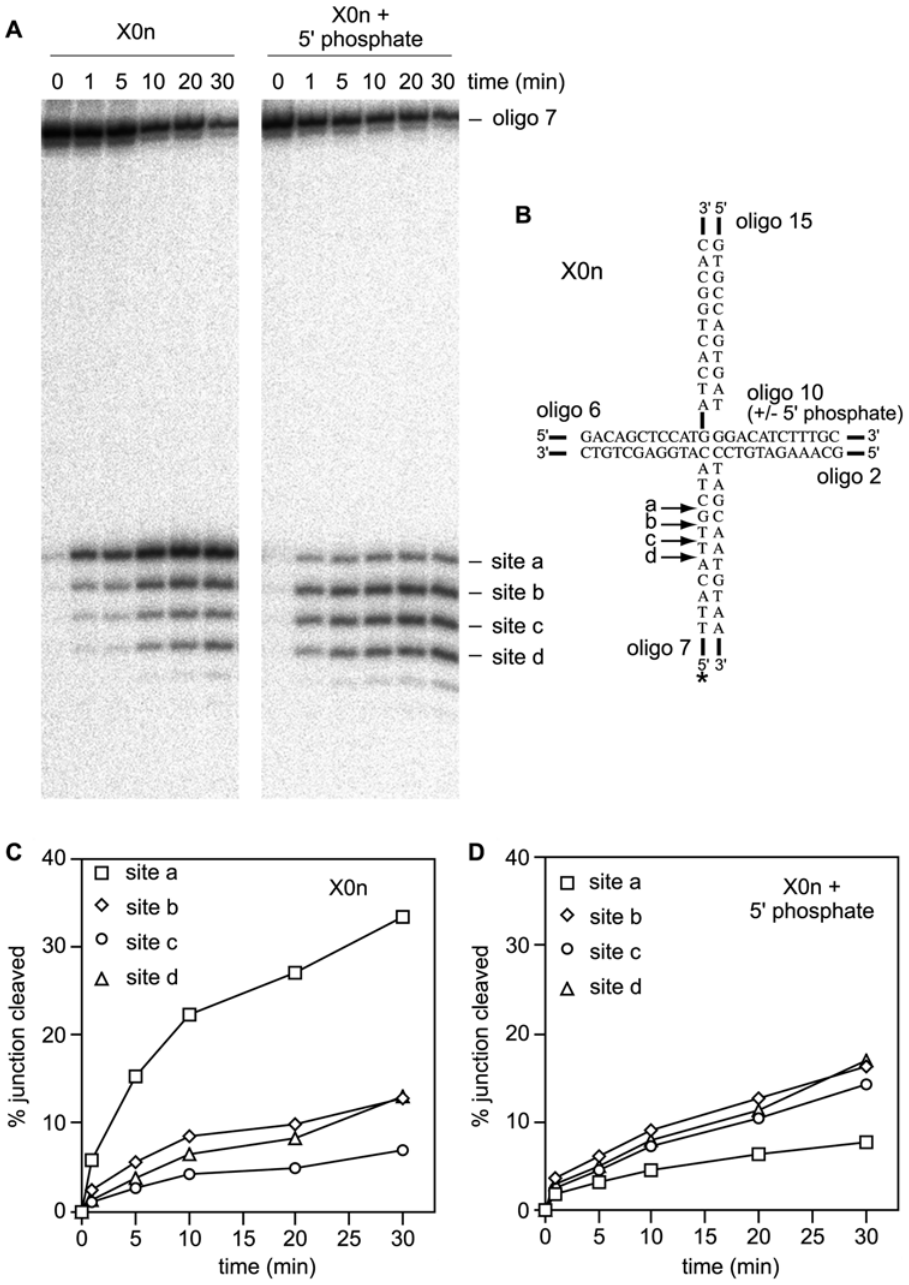
Figure 4. Effect of a 5 9 phosphate at the nick site in X0n on cleavage site preference by Mus81-Eme1. ( A ) Denaturing gels showing time courses of cleavage at sites a–d in X0n ( + / 2 5 9 phosphate at the nick site) by Mus81. Reactions (40 m l) contained 2 nM junction DNA and 0.2 nM Mus81-Eme1. ( B ) Schematic showing the core nucleotide sequences in X0n and the main sites of cleavage by Mus81. ( C and D ) Mean data from three experiments like shown in A . Error bars are omitted for the sake of